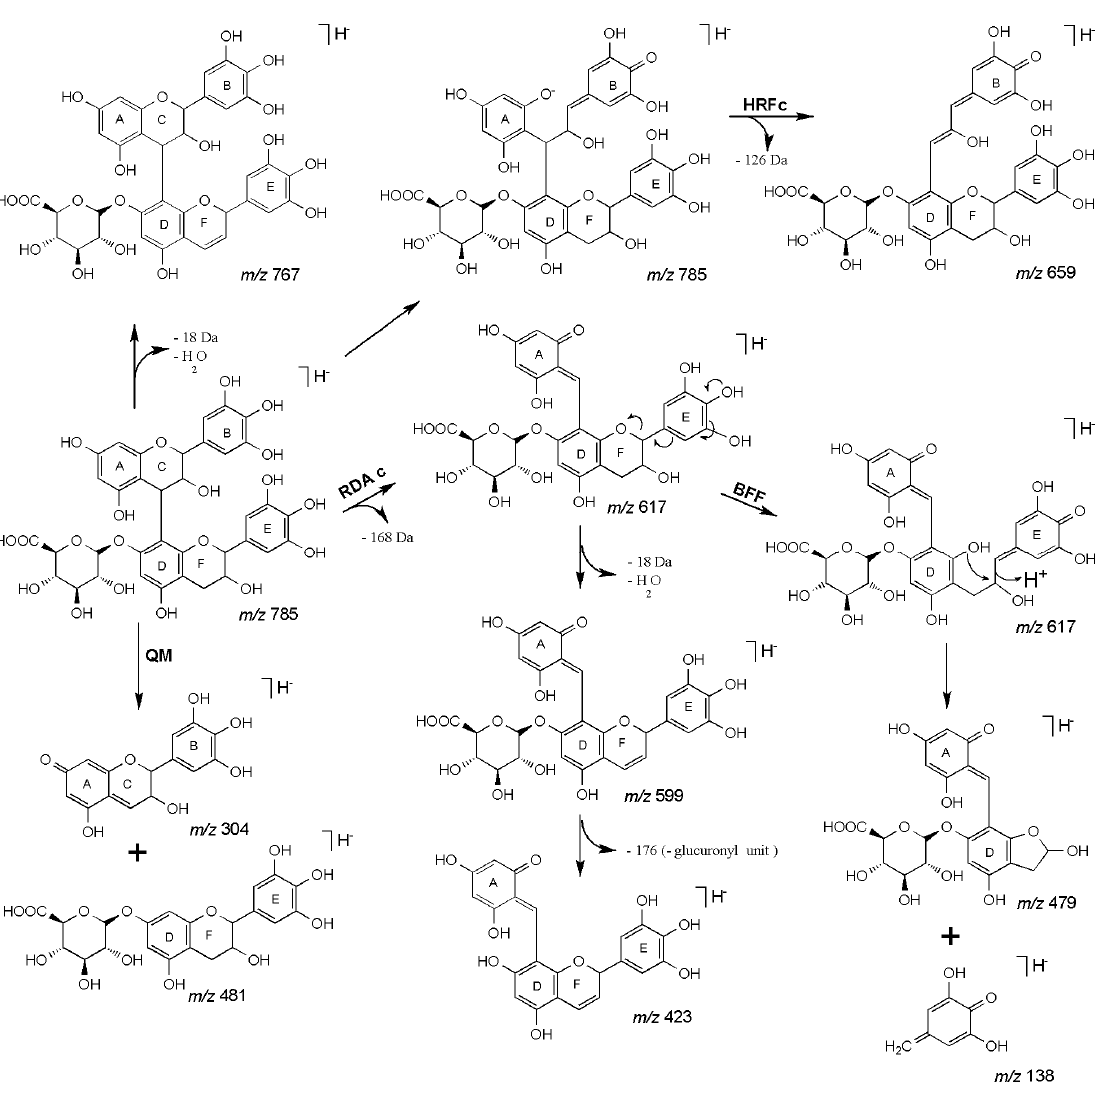
Figure 3. Characteristic fragmentation pathways of B-type proanthocyanidins proposed for the glucuronide dimer identified in the enriched fractions from roots of P. biglobosa .